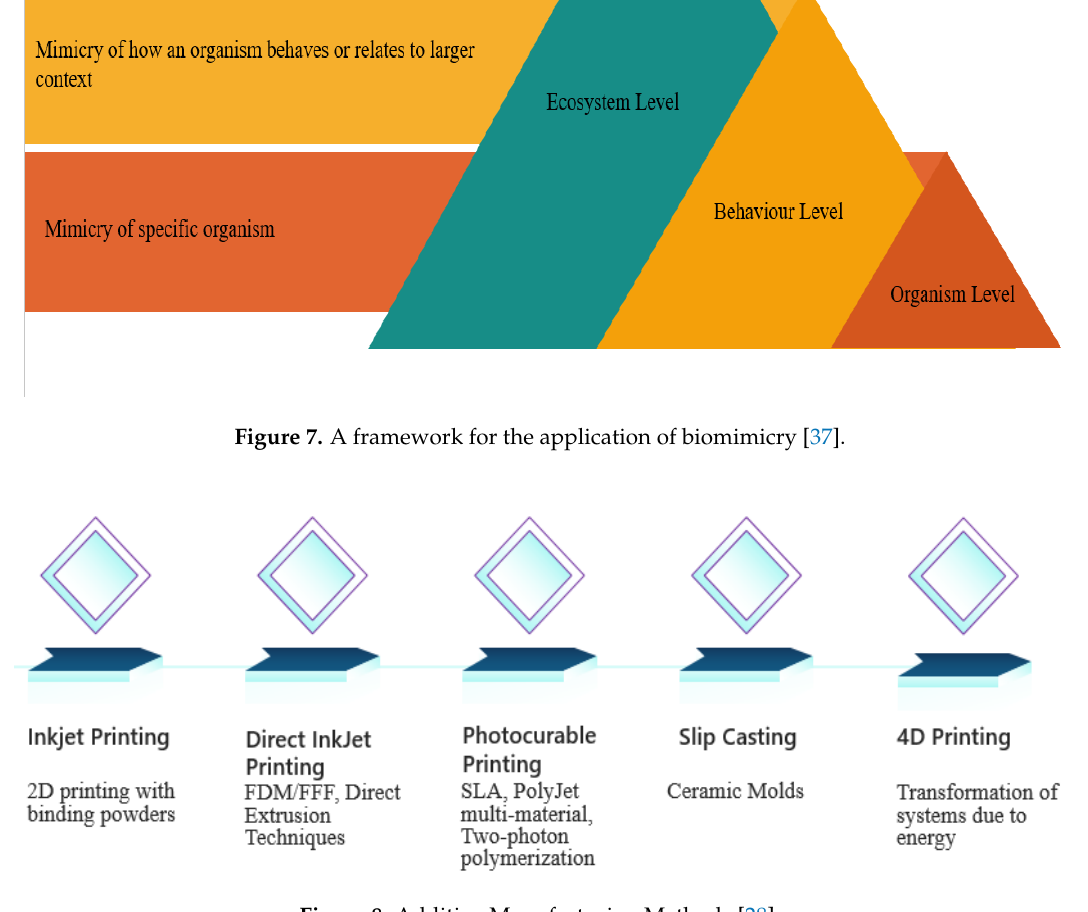
Figure 8. Additive Manufacturing Methods [28]